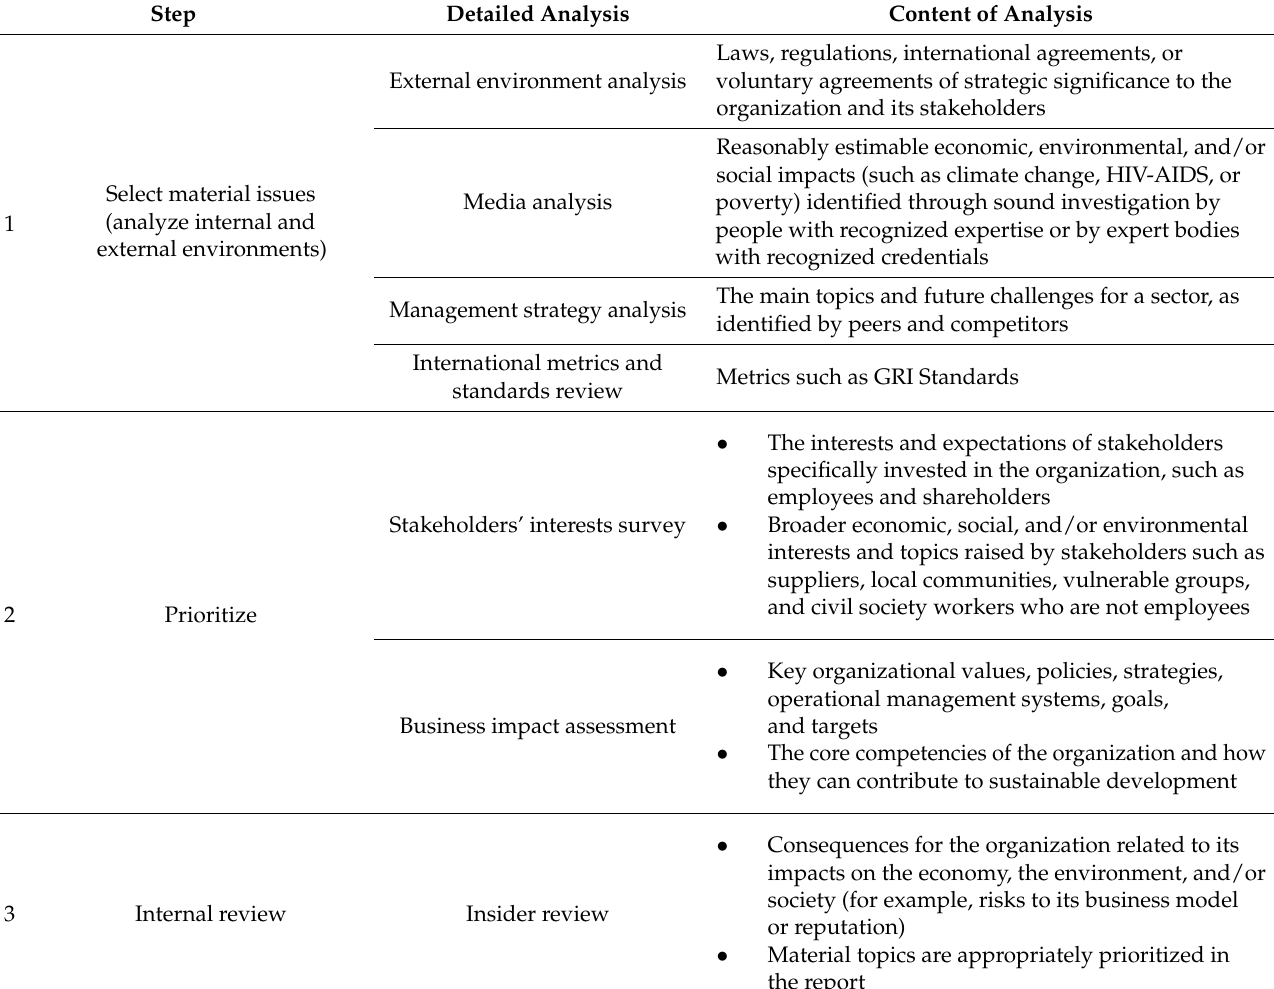
Table 2. Step-by-step materiality evaluation analysis